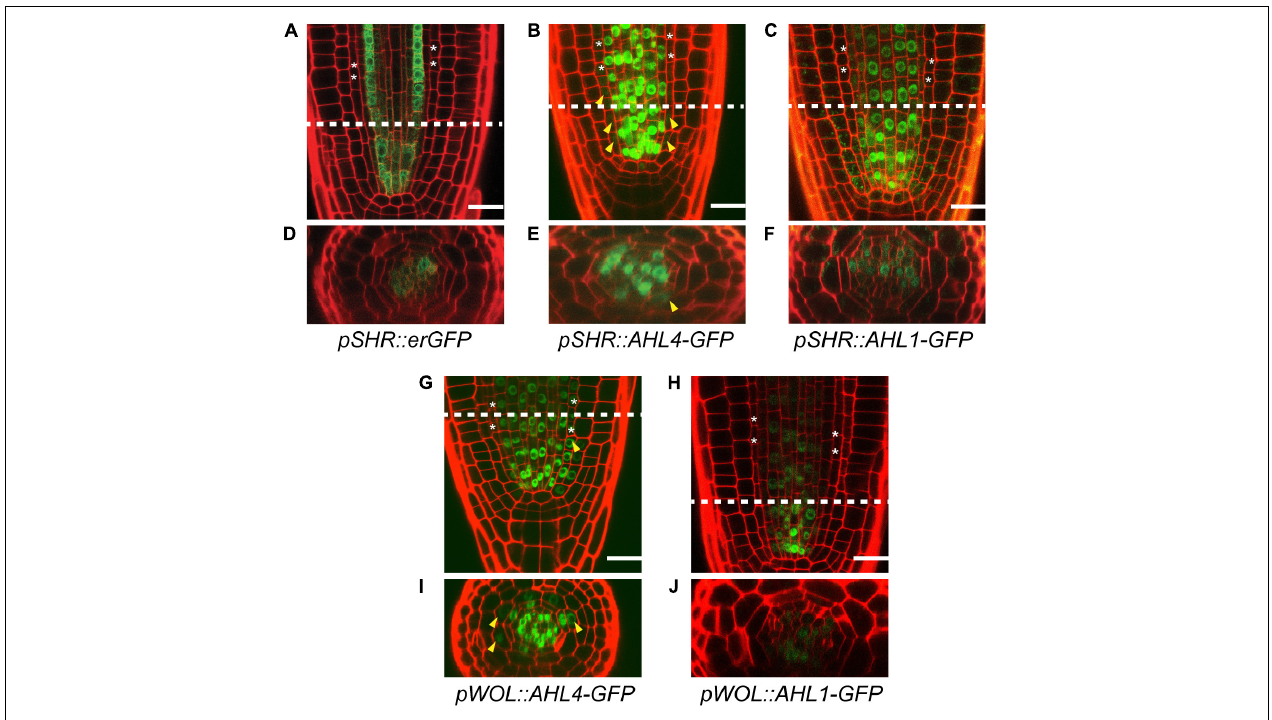
FIGURE 3 | Comparison of the intercellular movements of AHL1 and AHL4 under the SHR and WOL promoters. Longitudinal views of root apical meristems expressing pSHR:erGFP (A) , pSHR:AHL4-GFP (B) , and pSHR:AHL1-GFP (C) . (D–F) Cross-sectional images of the dashed-line positions of panels (A–C) . Longitudinal views of root apical meristems expressing pWOL:AHL4-GFP (G) and pWOL:AHL1-GFP (H) . (I,J) Cross-sectional images on the dashed-line positions of panels (G,H) . White asterisks, endodermis; yellow arrowheads, GFP moved to the endodermis; scale bars = 20 µ